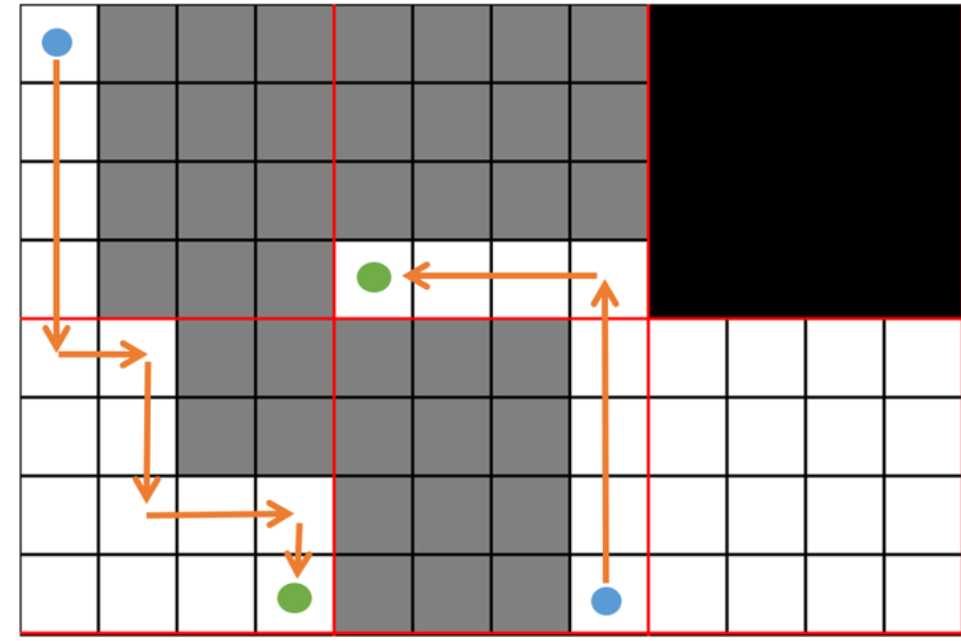
Figure 17. Building configuration satisfying the bubble rule.